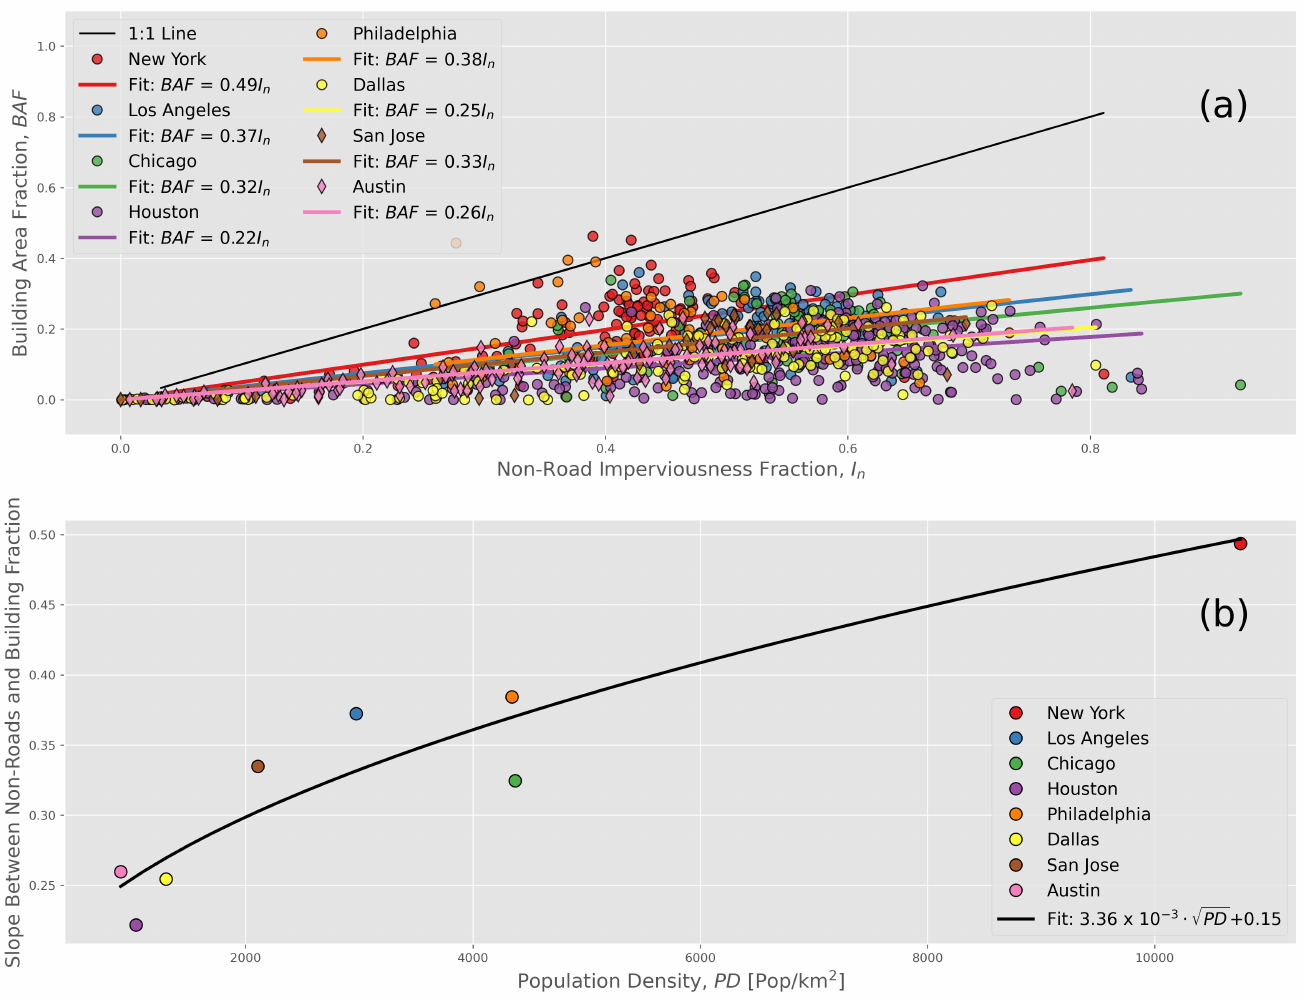
Figure 3. ( a ) Parameterization of building fraction based on the National Land Cover Database’s imperviousness fraction for non-road classifications. ( b ) Relationship between population density and the slope between non-road imperviousness and building area